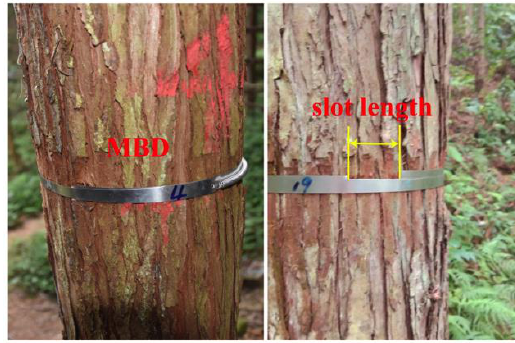
Figure 2. Manual band dendrometer (MBD) installed at breast diameter of Chinese fir.